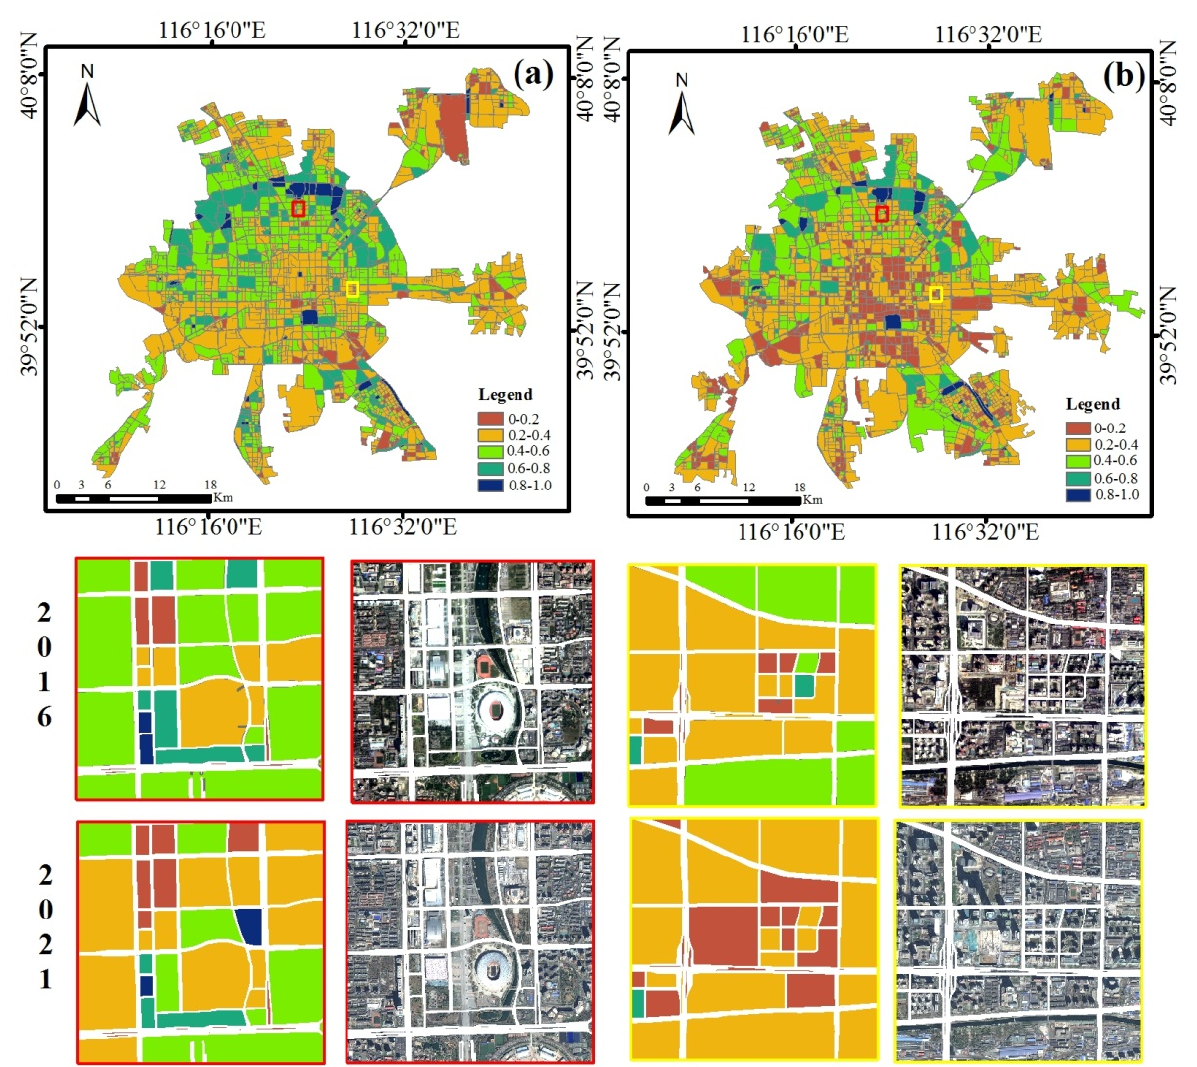
Figure 10. ( a , b ) show the results of the vegetation fraction in Beijing in 2016 and 2021, respectively. Note: the red and yellow boxes represent the detailed comparison results of the vegetation fraction and GaoFen-1 images for the two regions during 2016–2021.